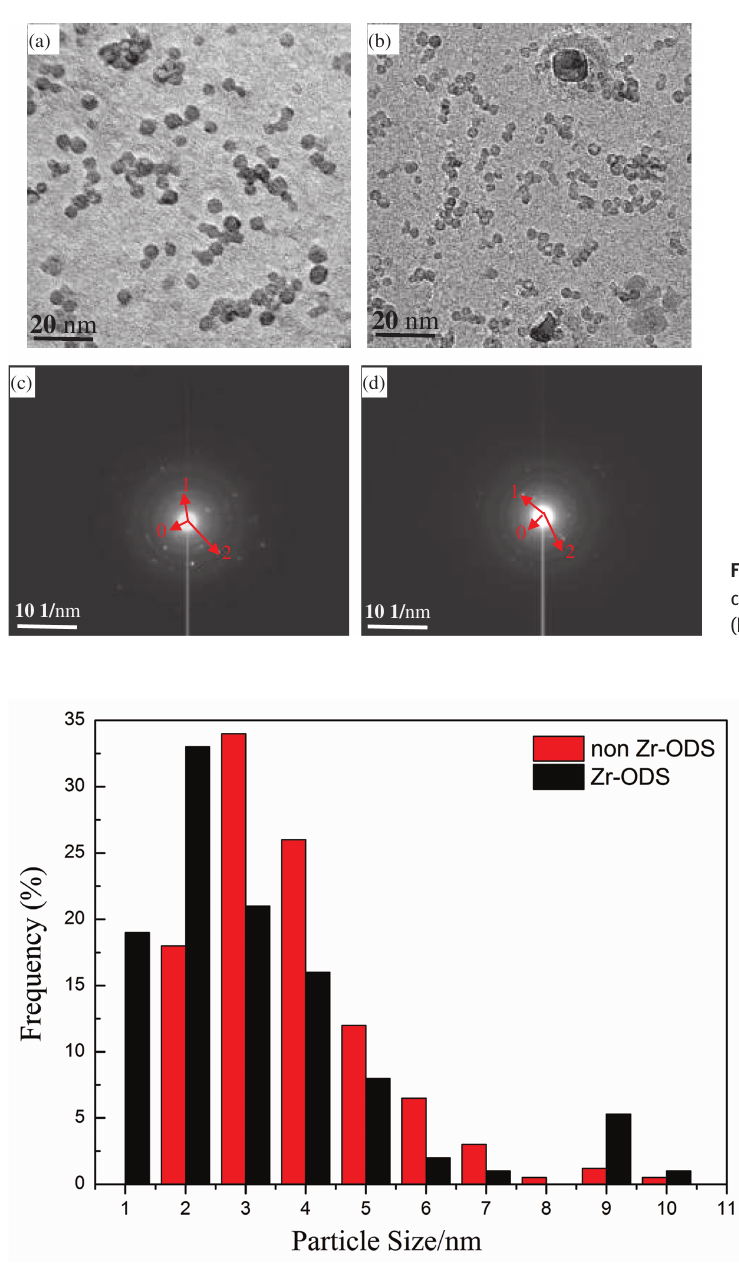
Figure 4: Size distributions of the oxides retrieved in a carbon replica from the ODS